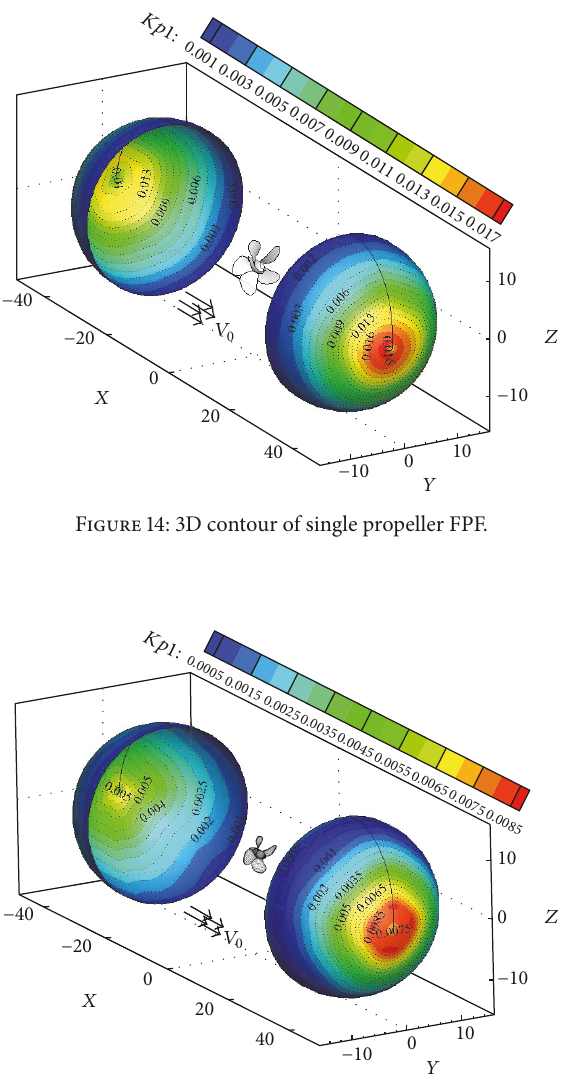
Figure 15: 3D contour of front propeller FPF.